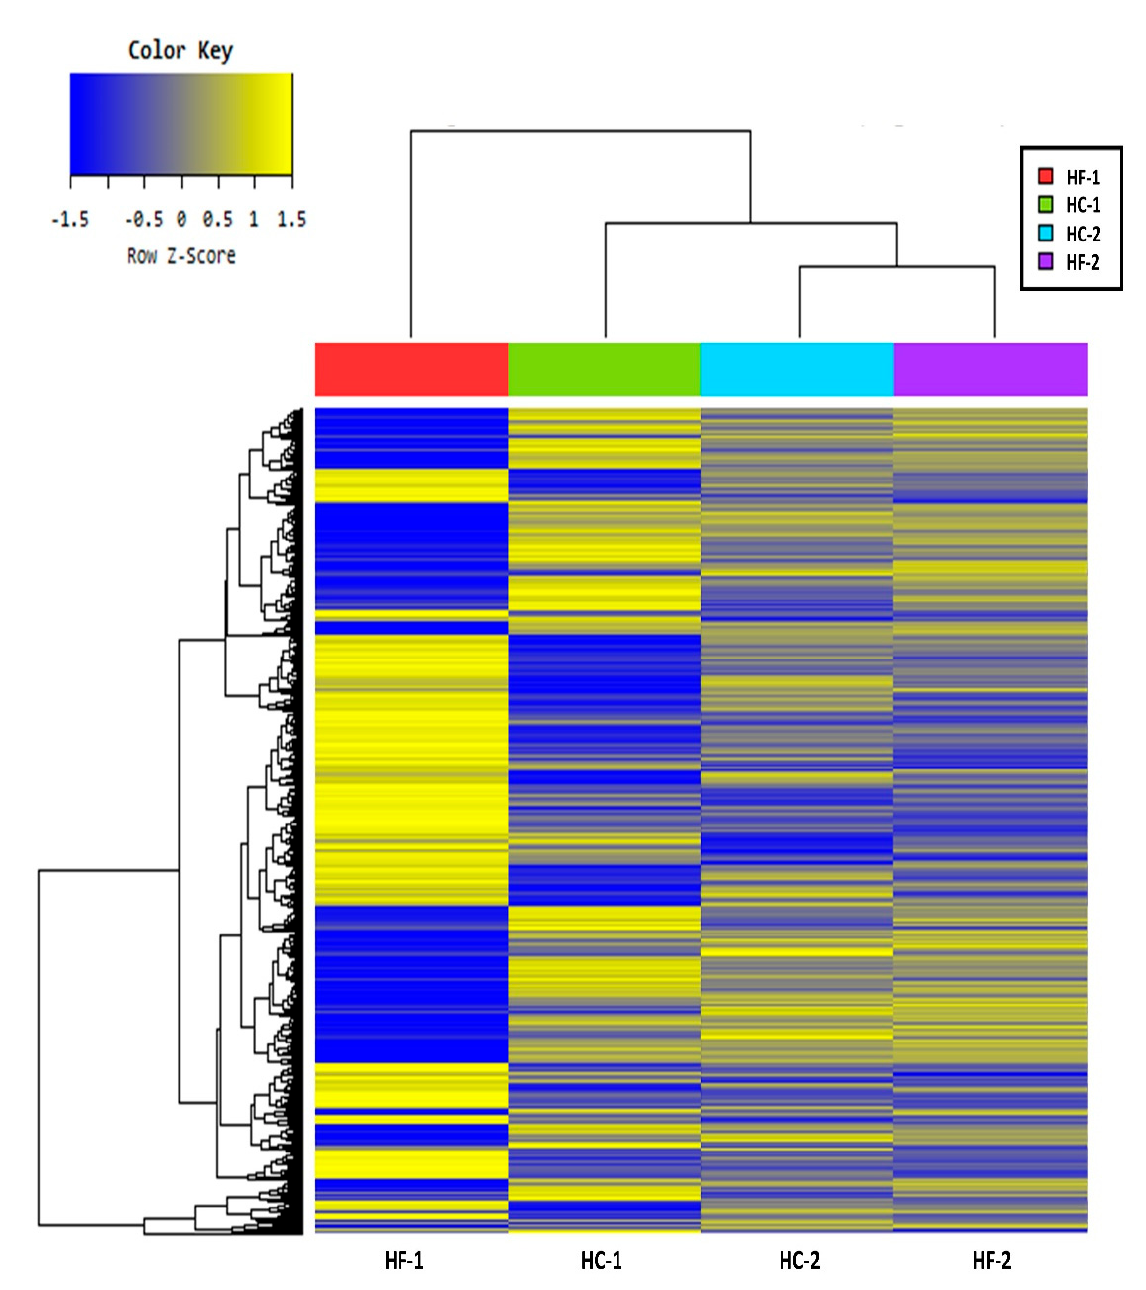
Figure 7. Hierarchical clustering analysis by Euclidean distance and complete linkage showing the similarity of genes and treatments based on normalized value of expression level from the significant list. HF-1, high-forage diet; HC-1, high-concentrate diet; HC-2, high-concentrate diet; HF-2, high-forage diet.